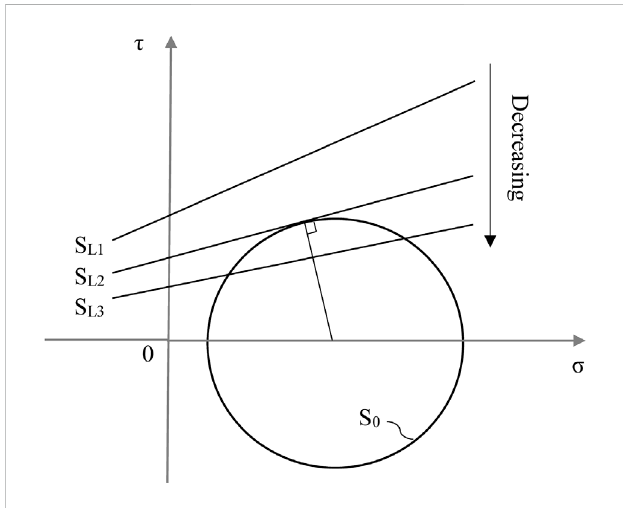
Calculation method of the deterioration of clay mechanical properties based on Mohr